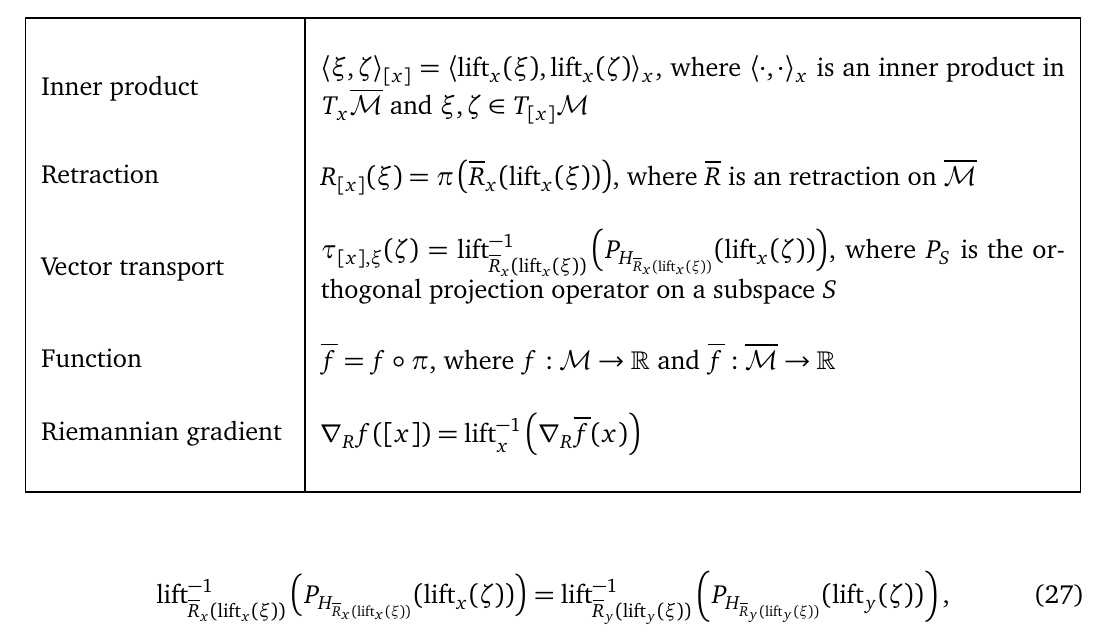
Table 2: Optimization primitives of M